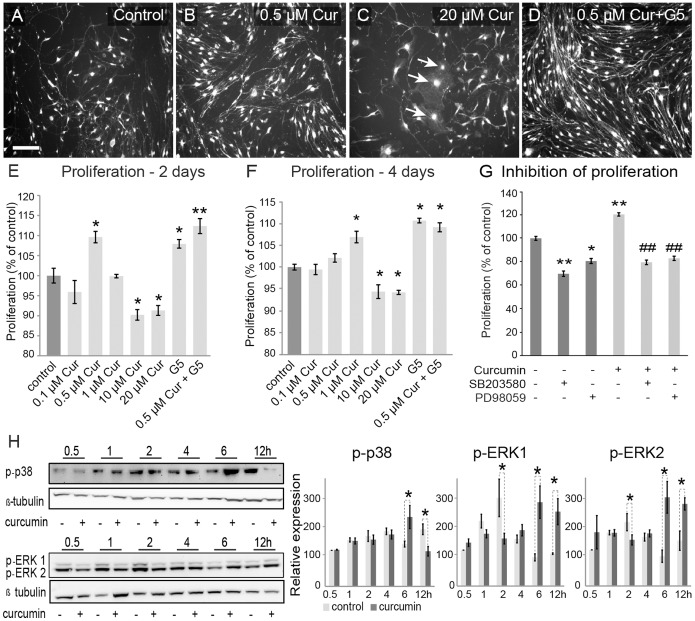
Low-dose curcumin treatment increases OEC proliferation.(A–D). Increased proliferation of OECs was observed after treatment with 0.5 µM curcumin (B) or 0.5 µM curcumin combined with G5 supplement (D); cells appeared to have longer processes and formed a net-like structure. Cells treated with higher concentrations of curcumin (C) displayed a more flattened morphology (arrows) and the number of cells was lower compared to the control (A). Scale bar = 100 µm in A–D. (E–F) Quantification of the proliferation rate in MTS assays. (E) After two days in culture 0.5 µM curcumin with or without G5, and G5 supplement alone had significantly higher proliferation compared to control treatment. Higher doses of curcumin (10, 20 µM) showed a significant decrease in OEC proliferation compared to control treatment p<0.05 (*), p<0.001 (**). After four days in culture, 1 µM curcumin, 0.5 µM curcumin with G5, and G5 supplement alone significantly increased OEC proliferation; whereas 10 µM and 20 µM curcumin decreased proliferation compared to control treatment (F). p<0.05(*), p<0.001(**), one way ANOVA post-hoc Tukey test. (G) ERK (PD98059) and p38 kinase (SB203580) inhibitors blocked curcumin-induced proliferation of OECs p<0.05 (*); p<0.01 (**) compared with control; p<0.01 (##) compared with cultures treated with curcumin alone; (n = 30–36 cells per treatment). Values are expressed as mean ± s.e. of triplicates. Low-dose curcumin induced transient-activation of ERK and p38 MAP kinases in OEC cells (H). Whole cell extracts (40 µg for p–p38 and 20 µg for p-ERKs) from OECs treated with and without curcumin (0.5 µM) for the indicated time periods were subjected to western blot analysis using antibodies against phospo-ERK1/2 and phospo-p38. Data represent the mean of three independent experiments ± s.e. Statistical significance was determined by Student’s t-test p<0.05 (*). Levels of β-tubulin were used as loading control.